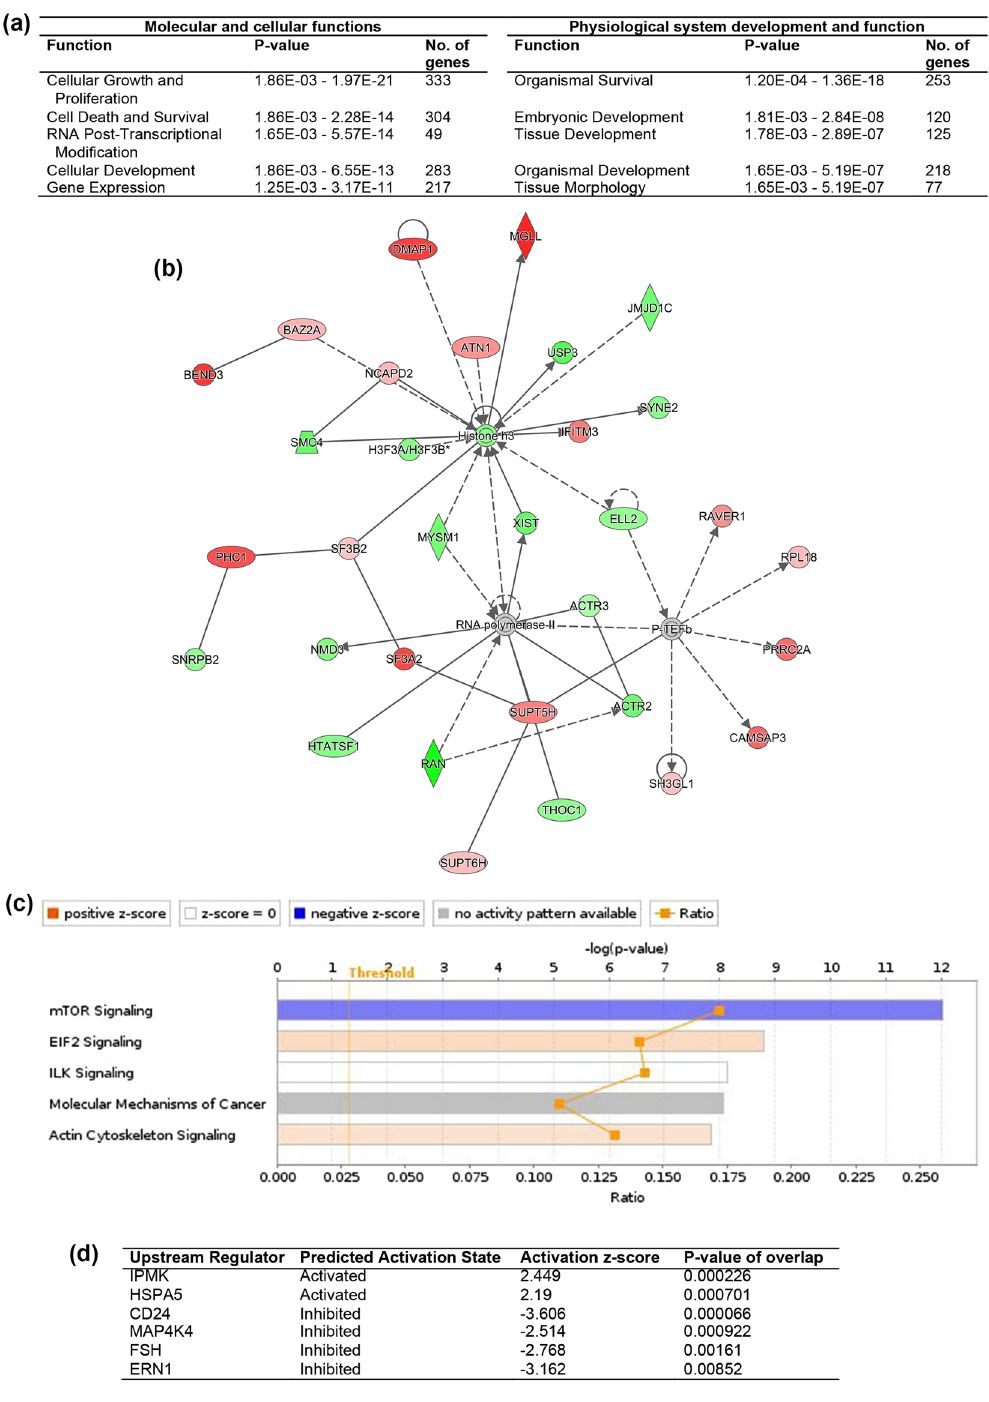
Figure 3. IPA analysis of DEGs from the comparison between miNT blastocysts derived from depleted cells cultured in the absence of TSA and SCNT blastocysts derived from depleted cells cultured in the presence of TSA (n = 3 to 4/group). ( a ) List of the top five biological functions. ( b ) Gene interaction network involved in DNA replication, recombination, and repair, gene expression, and cell cycle. Upregulated and downregulated genes are represented in red and green, respectively. The intensity of colour represents the degree of regulation. Colourless or grey nodes are genes involved in the network which were obtained from the Ingenuity Knowledge Base. The solid and dashed lines represent direct and indirect interactions, respectively. ( c ) The top five statistically significant canonical pathways. ( d ) List of upstream Our previous report showed that depleting mtDNA from donor cells prior to SCNT can prevent the transmis- sion of donor cell mtDNA to the embryo as these embryos harboured only oocyte mtDNA. Furthermore, the gene expression patterns of embryos produced from depleted cells were different to those of nondepleted cells 35 .